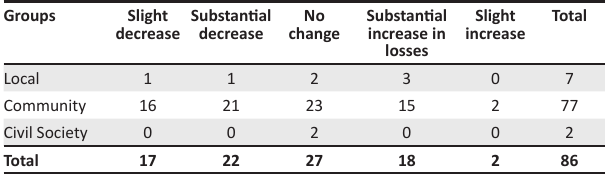
TABLE 13: Changes in disaster loss per informant groups.